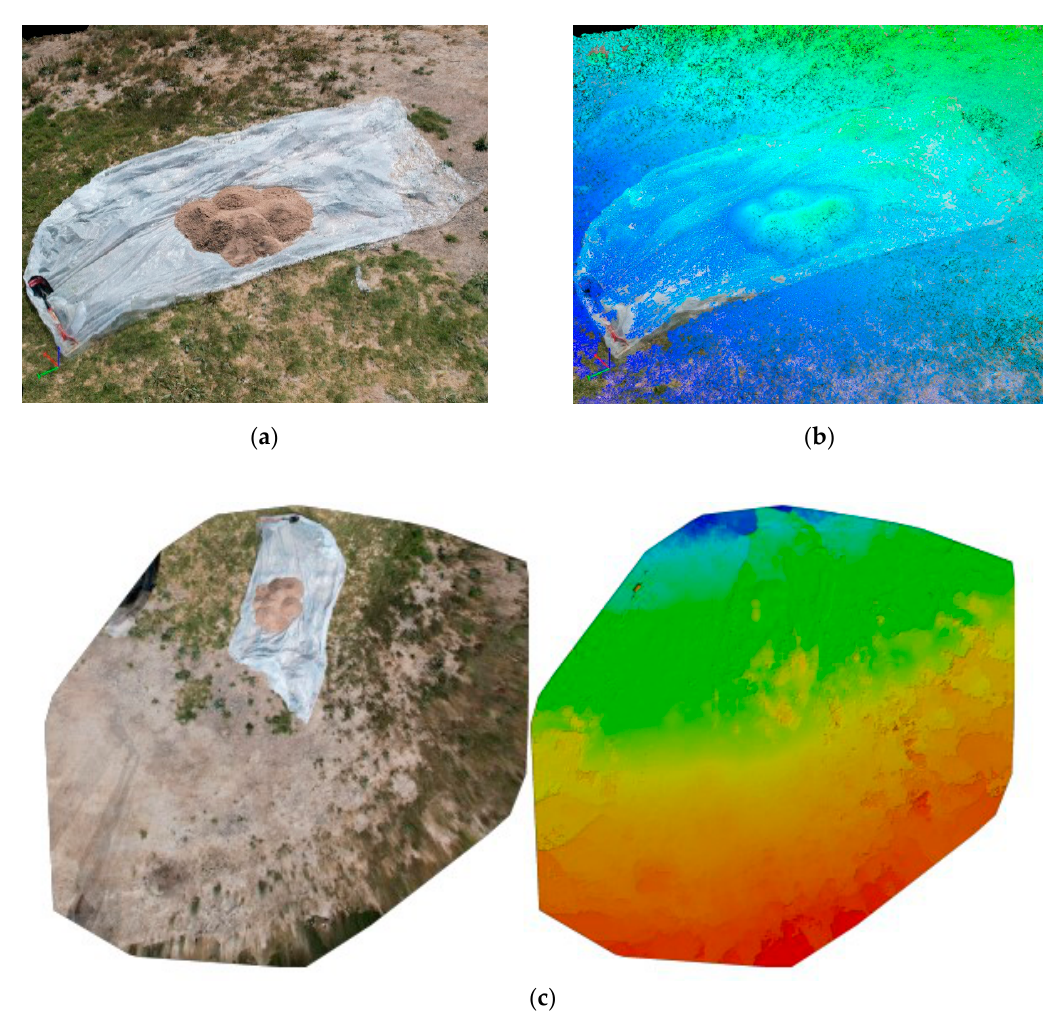
Figure 2. Representation of the generated point cloud model of the laboratory site: ( a ) Point Cloud Model; ( b ) Altitude Model; ( c ) Orthomosaic Model with its corresponding Digital Surface Model (DSM).